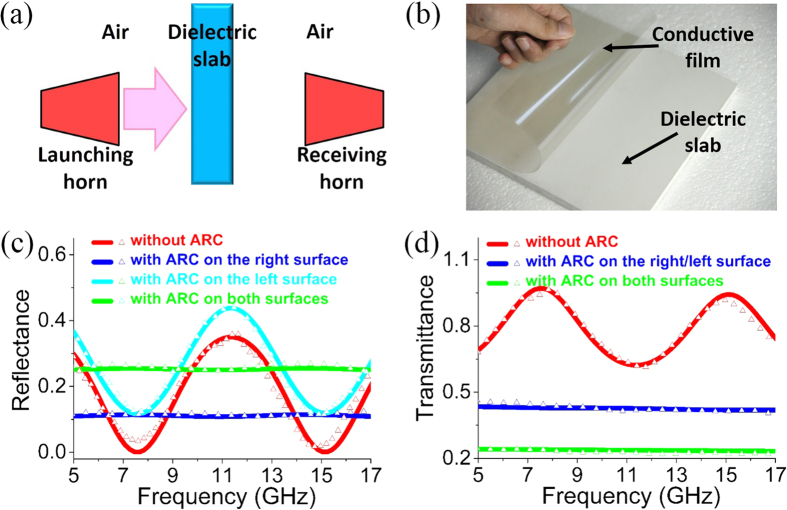
Experiments in free spaces for normal incidence.(a) Illustration of the experimental setup in free space. (b) Photo of the experimental sample. Simulated (solid lines) and measured (triangular symbols) (c) reflectance and (d) transmittance under normal incidence. The relevant parameters of the dielectric slab are ε1 = 4 + 0.03i and d1 = 9.9 mm. The conductive film has a sheet resistance of Rs = 370 Ω and a conducting layer thickness of 2.6 μm.